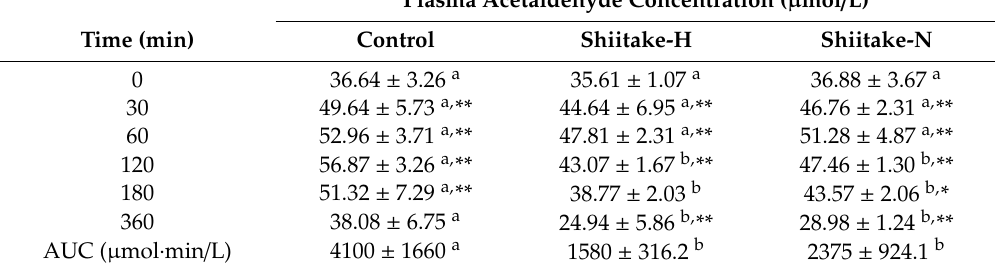
Table 2. E ff ect of shiitake extract on plasma acetaldehyde concentration after oral administration of ethanol.